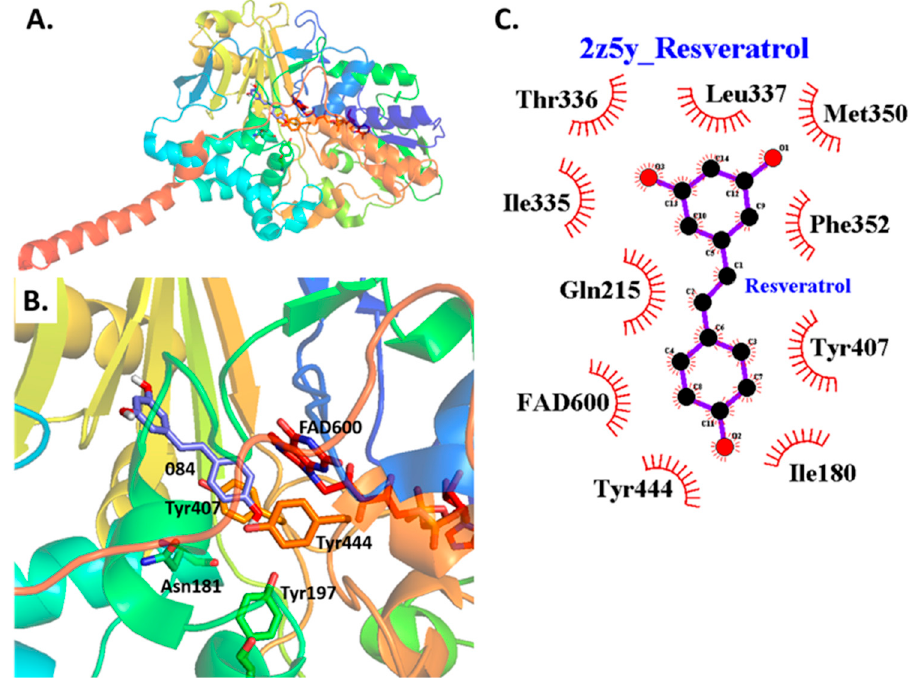
Figure 5. Molecular docking of trans -resveratrol on the MAO-A binding pocket. ( A ) 3D overview within the MAO-A active site. ( B ) Best orientation of trans -resveratrol on the MAO-A active site. ( C ) Details of polar and van der Waals interactions established with the residues on the MAO-A active site.